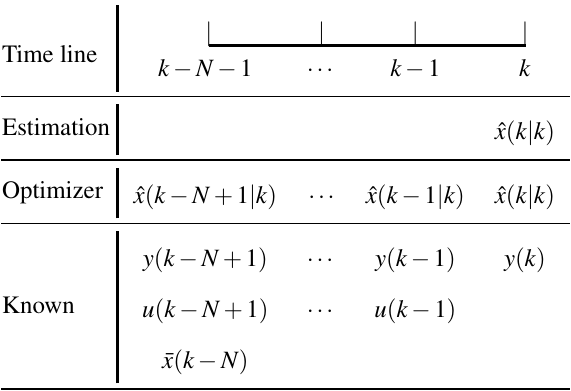
Table 3: RMHE problem